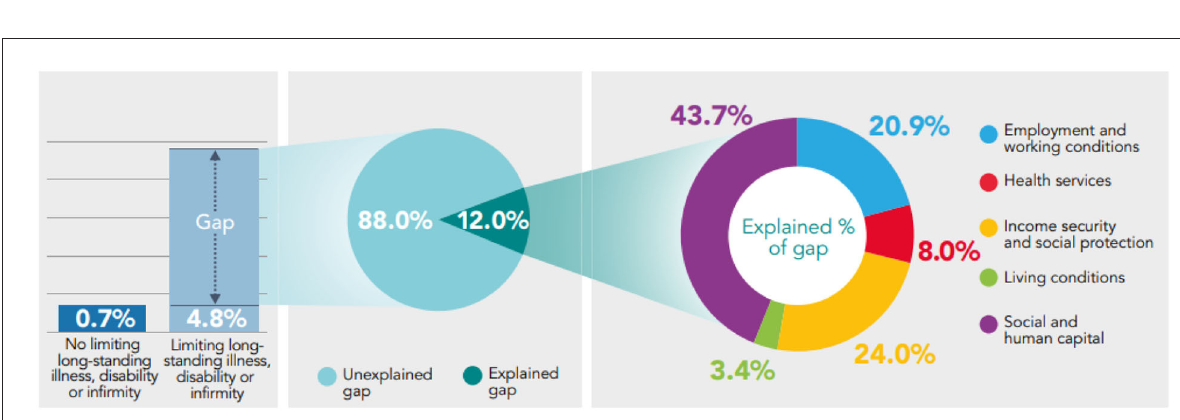
FIGURE8 Decomposing the gap in prevalence of low life satisfaction between those reporting a limiting long-standing illness, disability or infirmity, and those who do not using the Binder-Oaxaca methodology, persons aged 16 + , Wales, 2016–17 to